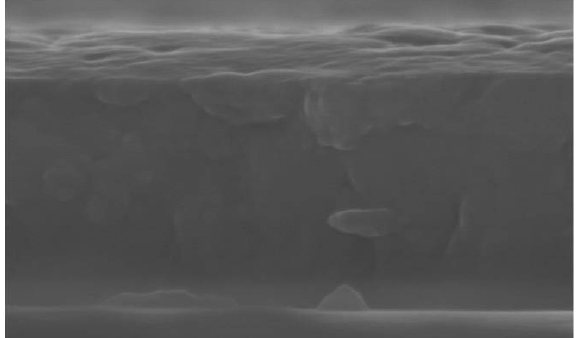
Figure 7. Cross-sectional SEM image of the CdS film grown by the